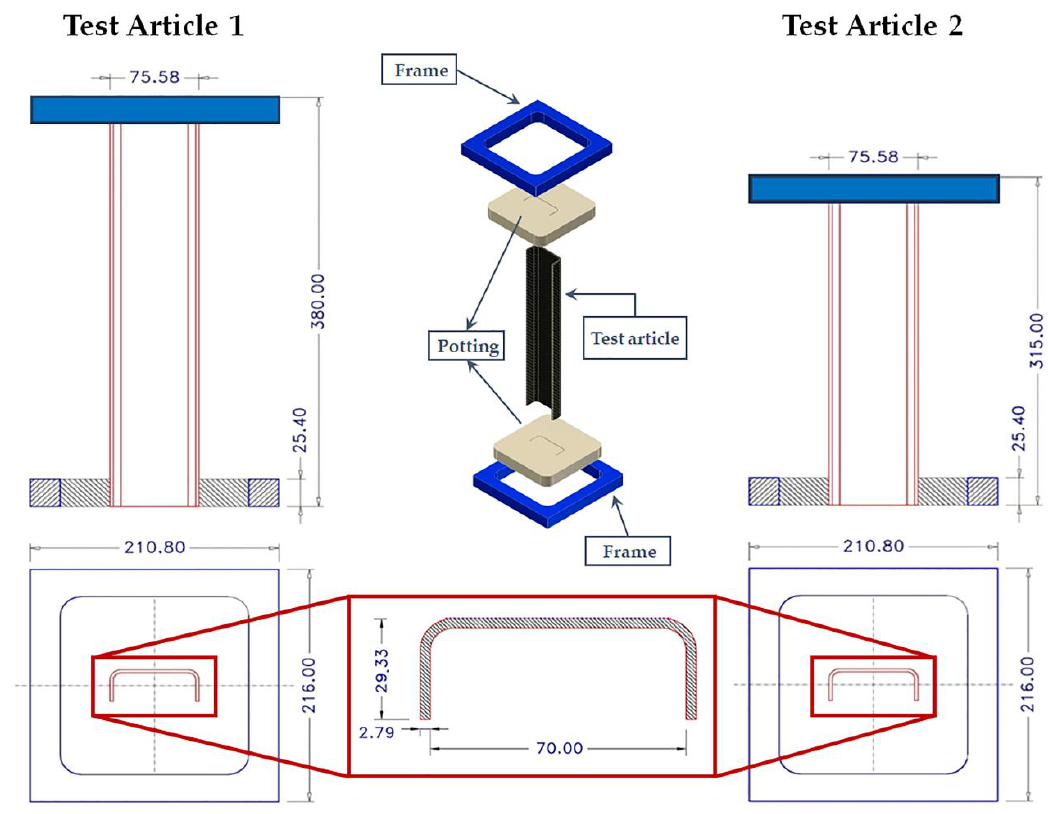
Figure 2. Geometrical description and boundary conditions. Table 1. Mechanical properties of the lamina.